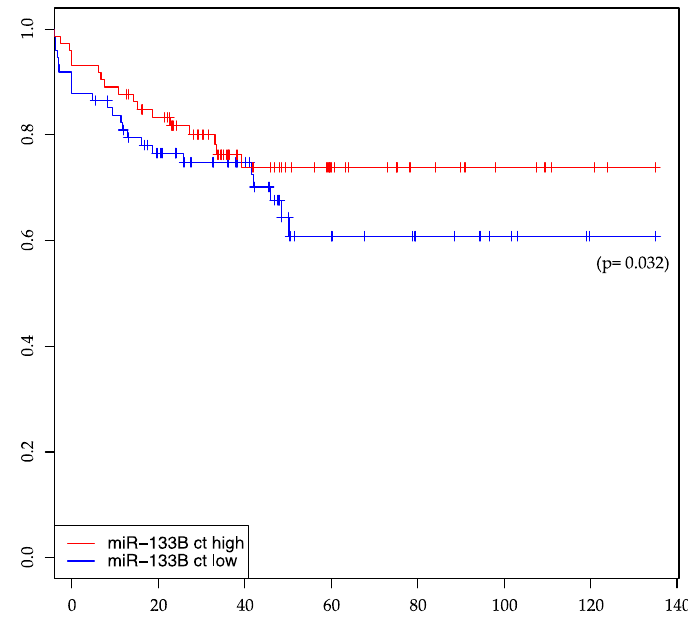
Figure 3. miR-133b distant-metastasis-free survival plot.